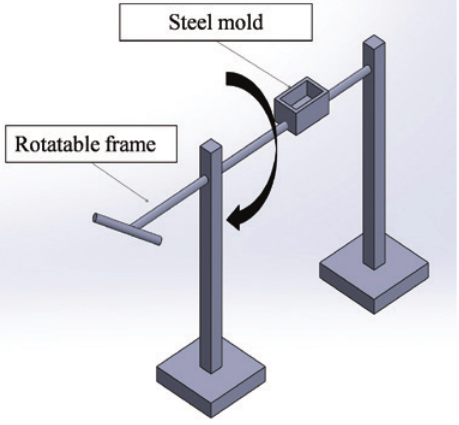
Figure 15: Apparatus used in the turnover decanting process.